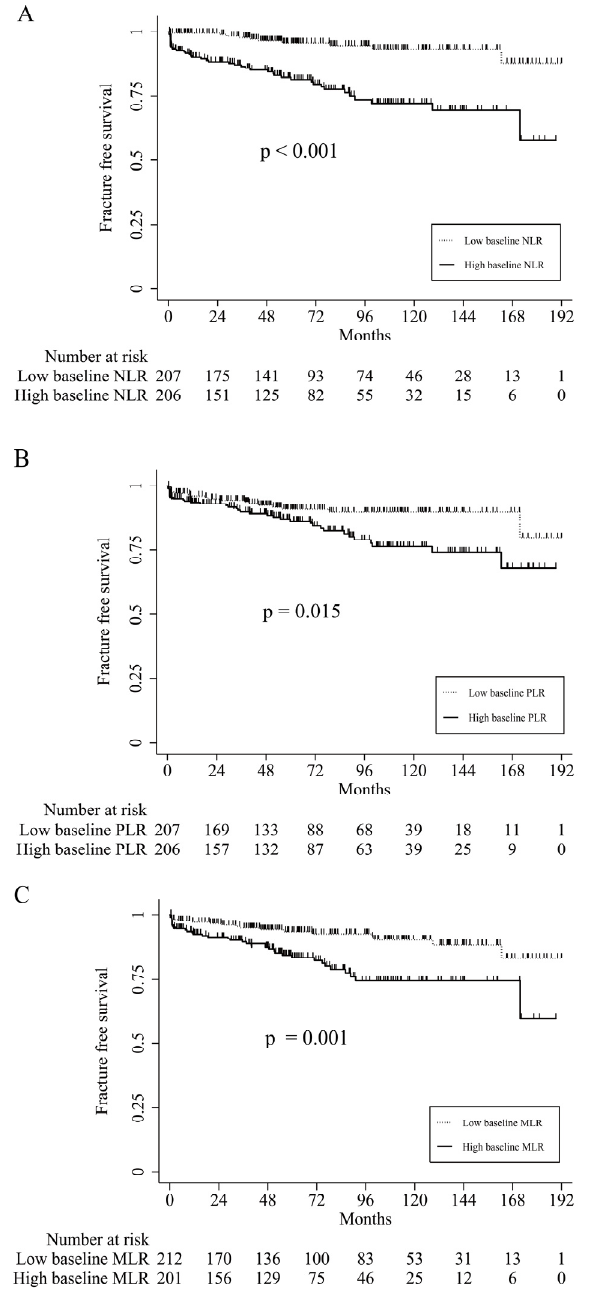
Figure 1. Comparisons of the fracture-free survival of patients with RA according to the neutrophil- to-lymphocyte ( A ), platelet-to-lymphocyte ( B ), and monocyte-to-lymphocyte ratios ( C